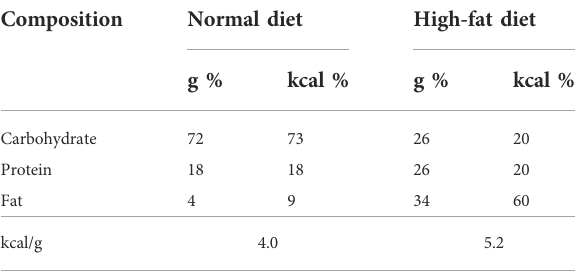
TABLE 2 Composition of normal chow diet and 60% high-fat